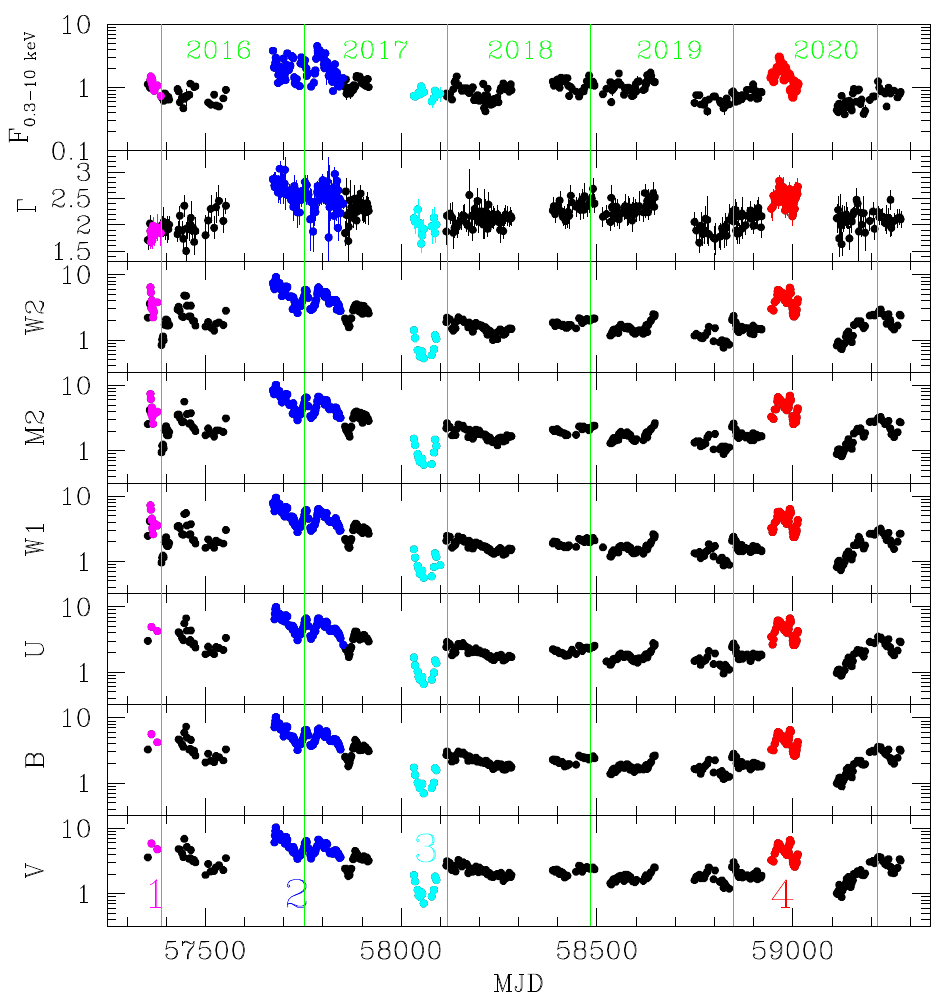
Figure 3. Multi-wavelength X-ray–optical lightcurve of OJ 287 taken with Swift since December 2015. The majority of data was obtained during the MOMO program. Panels from top to bottom: Observed X-ray flux in the band (0.3–10) keV in units of 10 − 11 erg/s/cm 2 , X-ray powerlaw photon index Γ x , Swift UVOT UV and optical fluxes (corrected for Galactic extinction) in units of 10 − 11 erg/s/cm 2 . Every year, observations are interrupted by ∼ 3 months when OJ 287 is in close proximity to the Sun such that Swift cannot observe. Selected epochs are marked in color: (1) The epoch near the 2015 binary impact flare, (2) the bright 2016–2017 outburst, (3) the 2017 optical-UV deep fade, and (4) the 2020 April outburst. Epochs (2) and (4) were interpreted as possible binary after-flares. Epochs like the deep fade in 2017 (feature 3) and the new low-state in September 2020 can be used